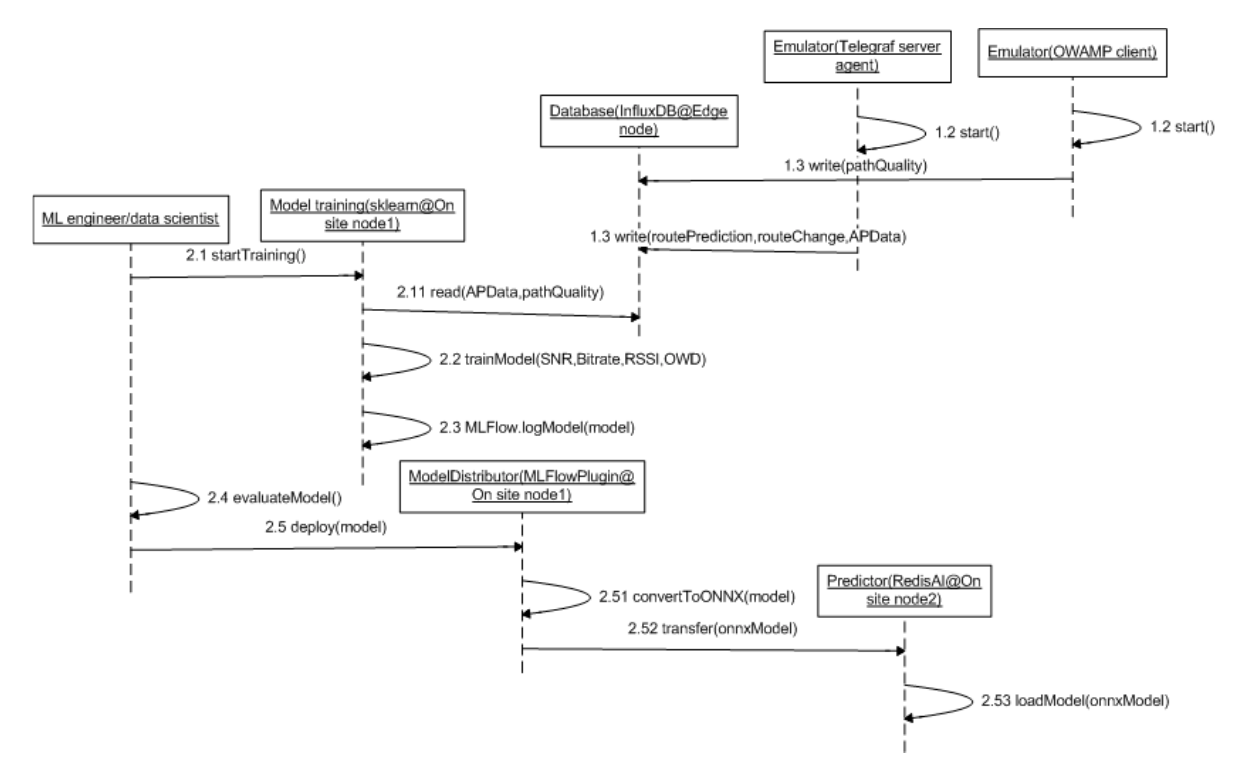
Figure 7. Sequence diagram illustrating model training and deployment.